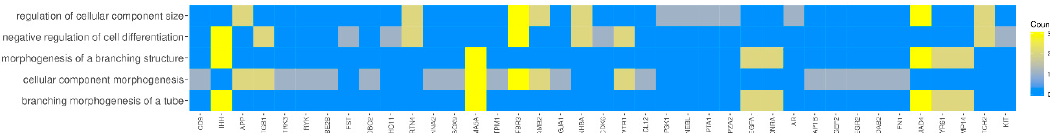
Figure 7. Heatmap showing the gene occurrence between differently expressed genes that belong to the “cellular component morphogenesis”, “negative regulation of cell differentiation”, “morphogenesis of a branching structure”, “regulation of cellular component size”, and “branching morphogenesis of a tube” GO BP terms. The yellow color is associated with gene occurrence in the GO Term. The intensity of the color corresponds to the amount of GO BP terms that each gene belongs to.